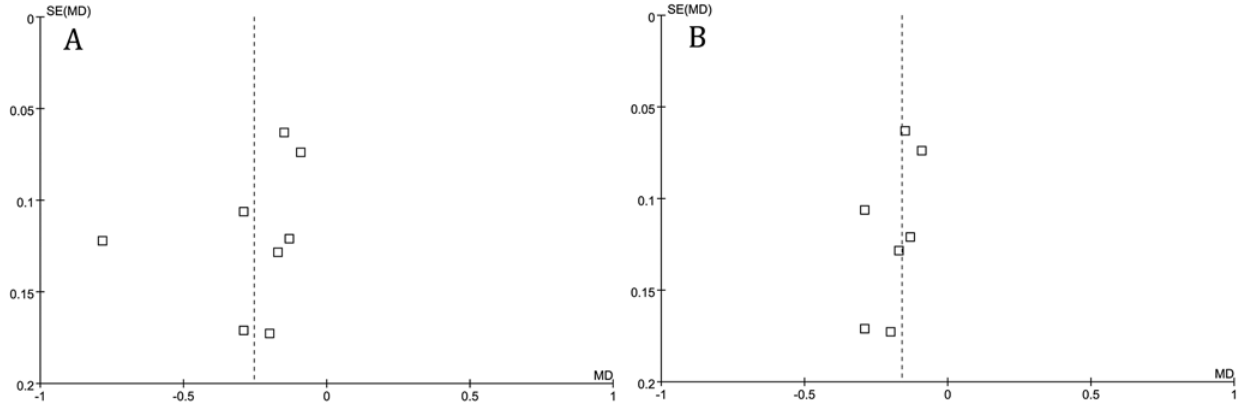
Fig 8. Significant visual asymmetry was revealed by the funnel plots (A) and the visual asymmetry disappeared after excluding one study with unreasonable results